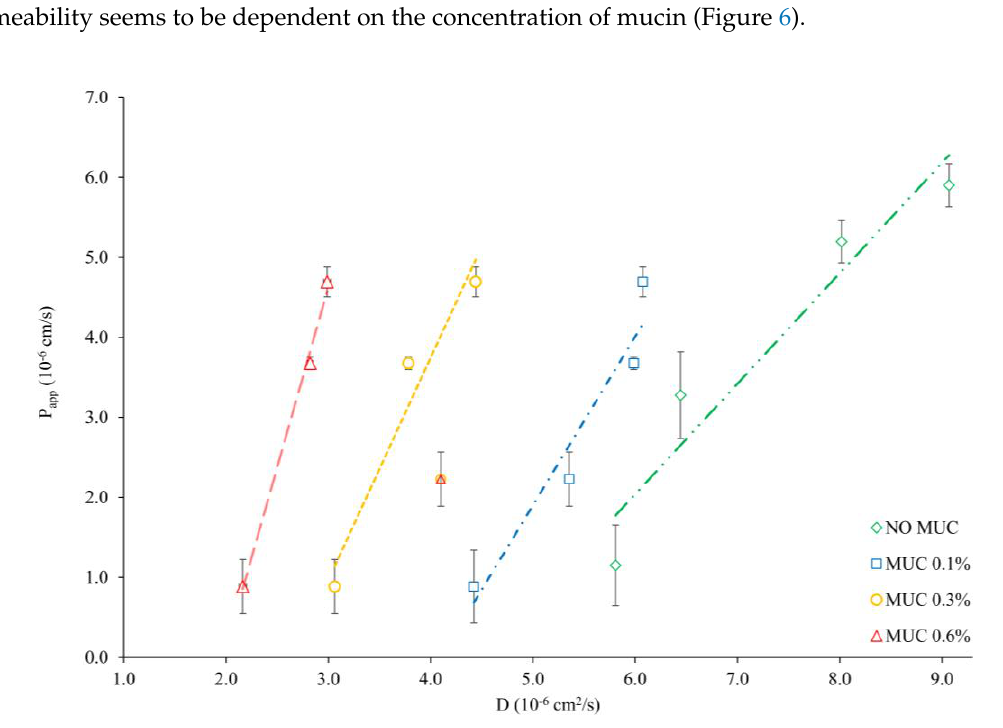
Figure 6. Correlation between apparent permeability (P app , average of 18 parallels and relative SD) and diffusivities (D) of CAF, ATN, NPR, and HYD in the absence (green diamonds), and presence of mucin (blue squares, 0.1% MUC; yellow circles, 0.3%; red triangles 0.6% MUC). For correlations at MUC 0.3% and 0.6% the data points related to HYD have not been taken into account.